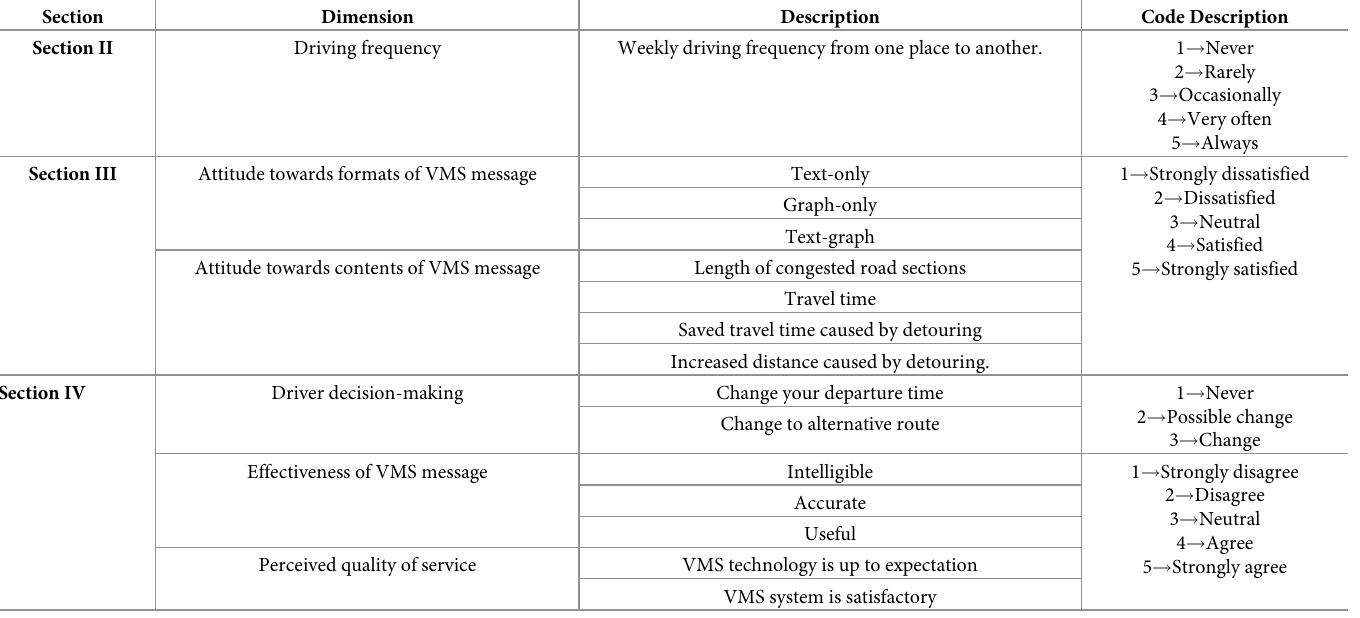
Table 2. Definitions of travel-related characteristics and attitude towards